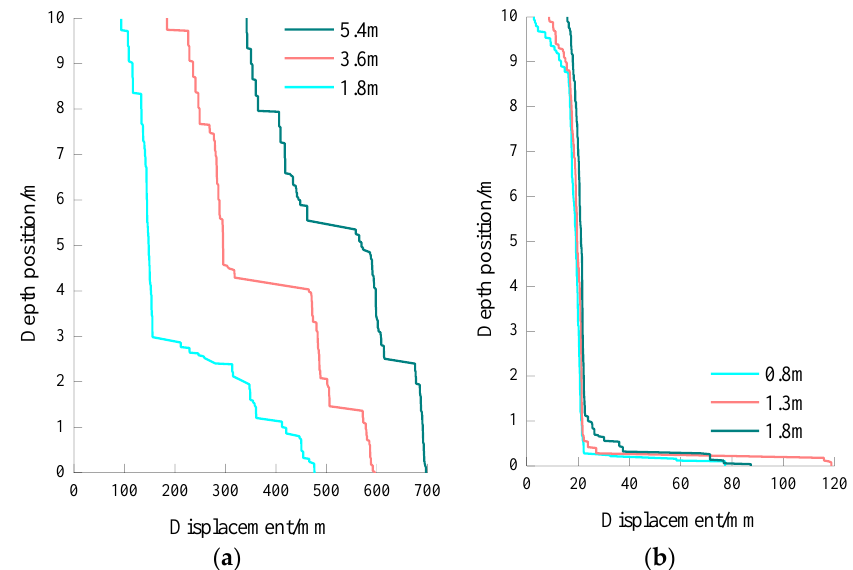
Figure 7. Simulated displacement curve of the surrounding rock: ( a ) Roof; ( b ) coal rib.